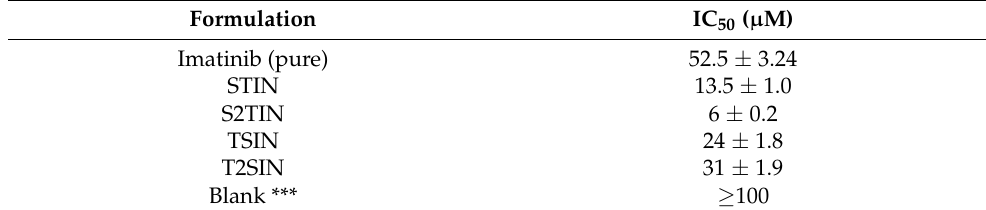
Table 3. IC 50 value of imatinib (pure) and its formulations at 72 h.